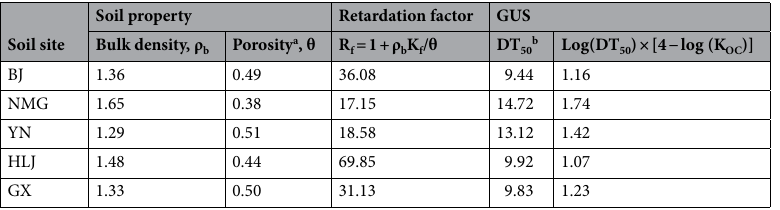
Table 4. Retardation factors and groundwater ubiquity score of QUN in soils. a Soil porosity = 1 − (soil bulk density/2.65). b DT 50 values from our previous report 16